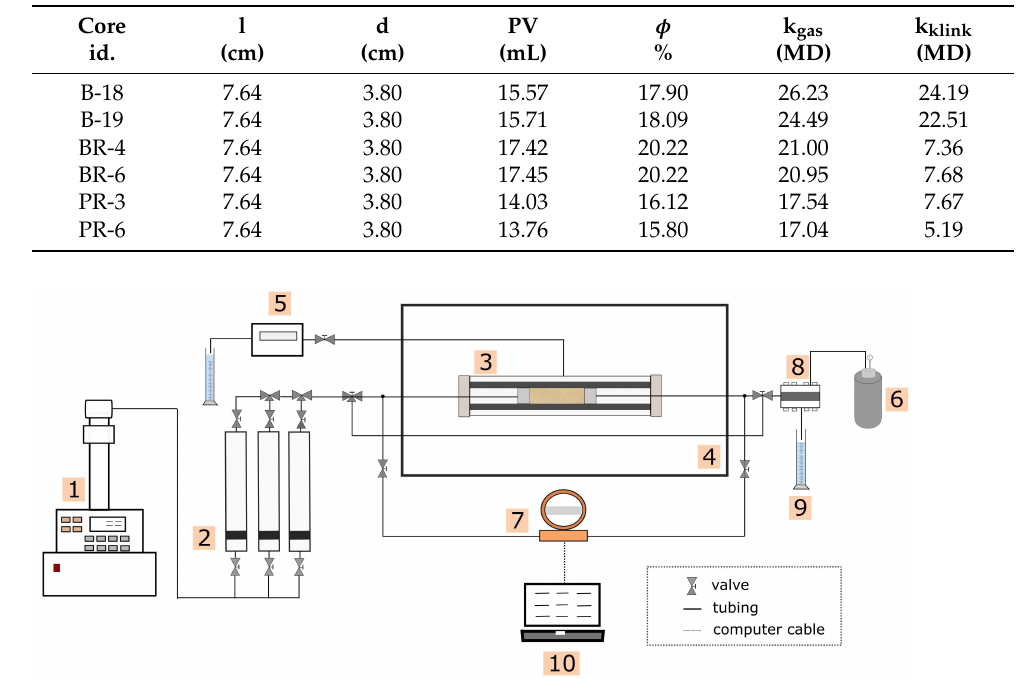
Figure 2. Simplified test set-up: 1—ISCO syringe pump, 2—stainless steel pistons, 3—Hassler- type core holder with core, 4—oven, 5—pump, 6—nitrogen cylinder and manometer,